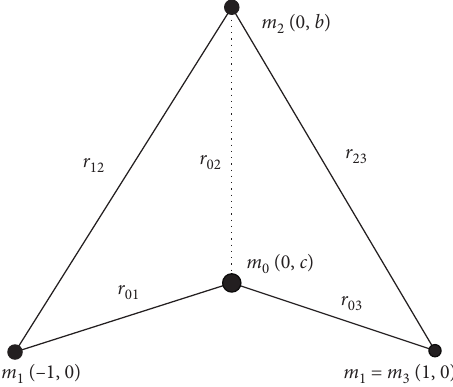
Figure 5: Concave four-body configurations with a pair of equal � m ) . masses ( m 1 3